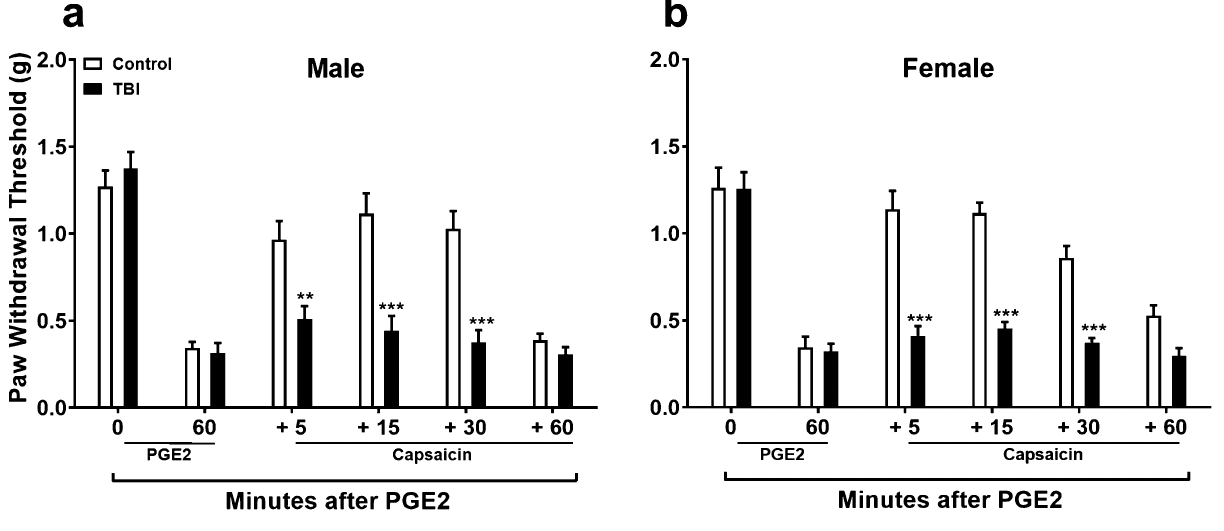
Figure 1. Long term assessment of diffuse noxious inhibitory control (DNIC) after mild TBI. Results show that the DNIC deficit remains impaired in both male ( a ) and female ( b ) mice at 12 weeks post-TBI. Data were analyzed by two-way repeated measures ANOVA using the Sidak method to correct for multiple comparisons. ** p < 0.01, *** p < 0.001 indicates significant difference between sham control and TBI. Error bars: SEM, n = 6/